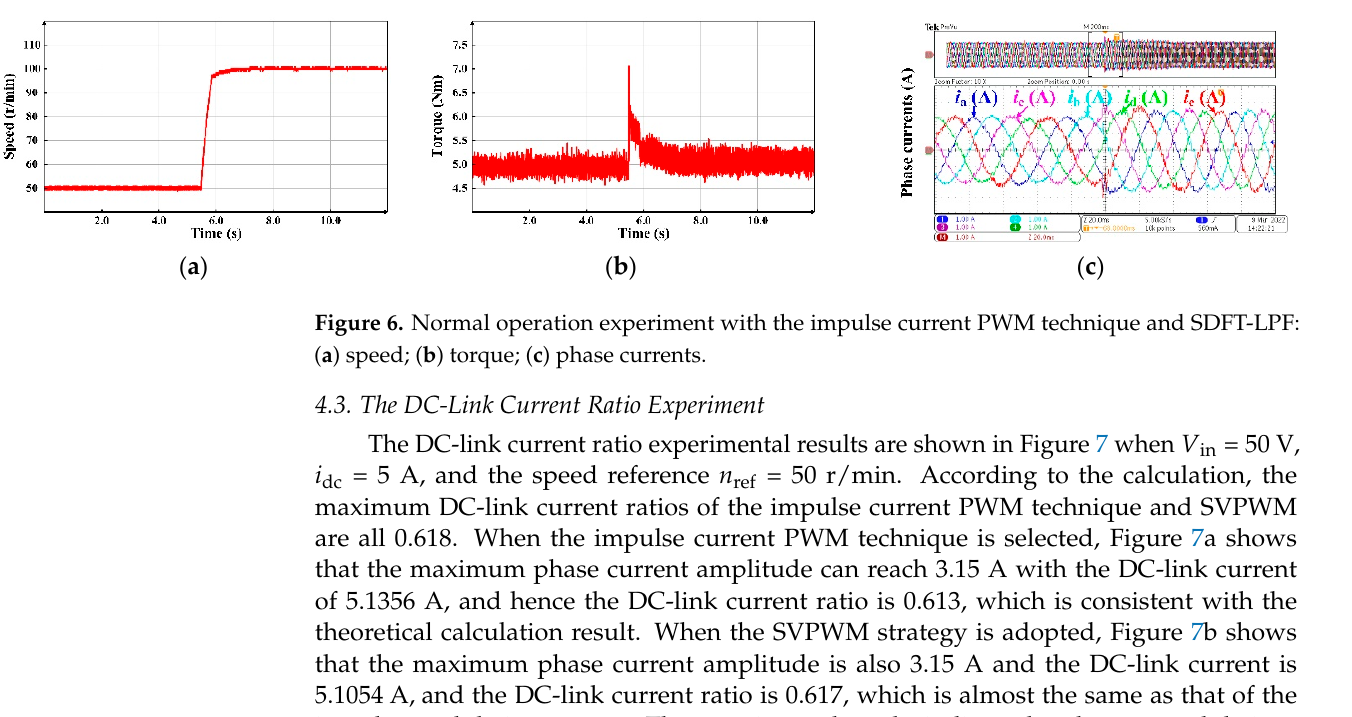
11 of 16 Table 1. Parameters of the driver. Symbol 90 μ F Table 2. Parameters of the five-phase dual-rotor PMSM. Symbol